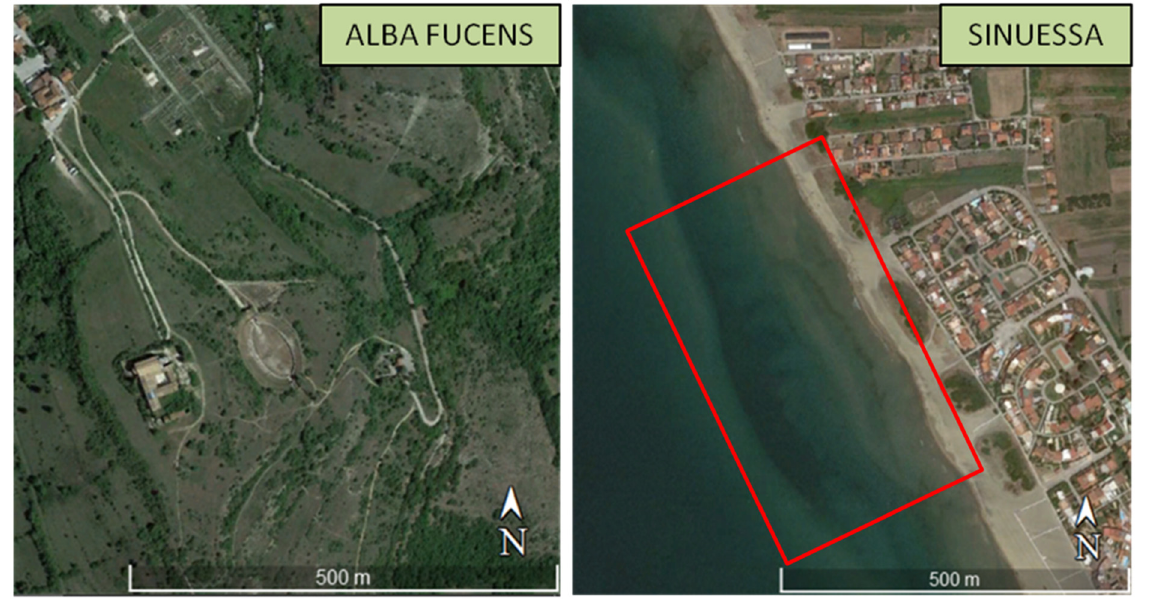
Figure 1. The Italian terrestrial Alba Fucens and marine Sinuessa (in the red AOI) archaeological sites (orthophotos by Google Earth © 2022) [50–52].